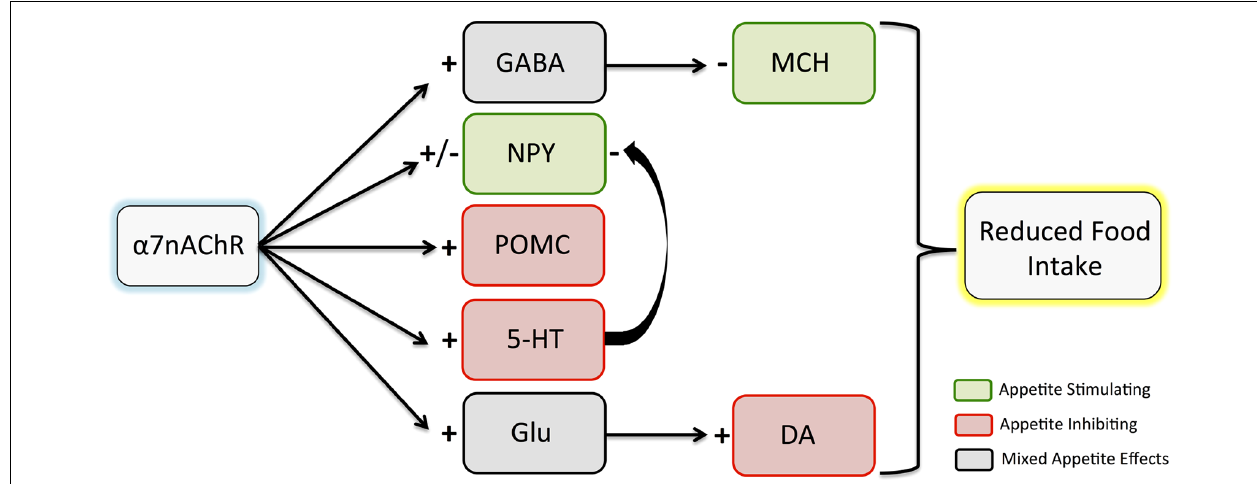
FIGURE 1 | Effects of α 7nAChR stimulation on hypothalamic neuropeptide and neurotransmitter release. Although there are complex interactions among pathways, it is hypothesized that the net effect of α 7nAChR stimulation leads to reduced food intake. Inhibitory effects are indicated with a minus sign, while excitatory effects are indicated with a plus sign. Note that both inhibitory and excitatory effects of α 7nAChR stimulation